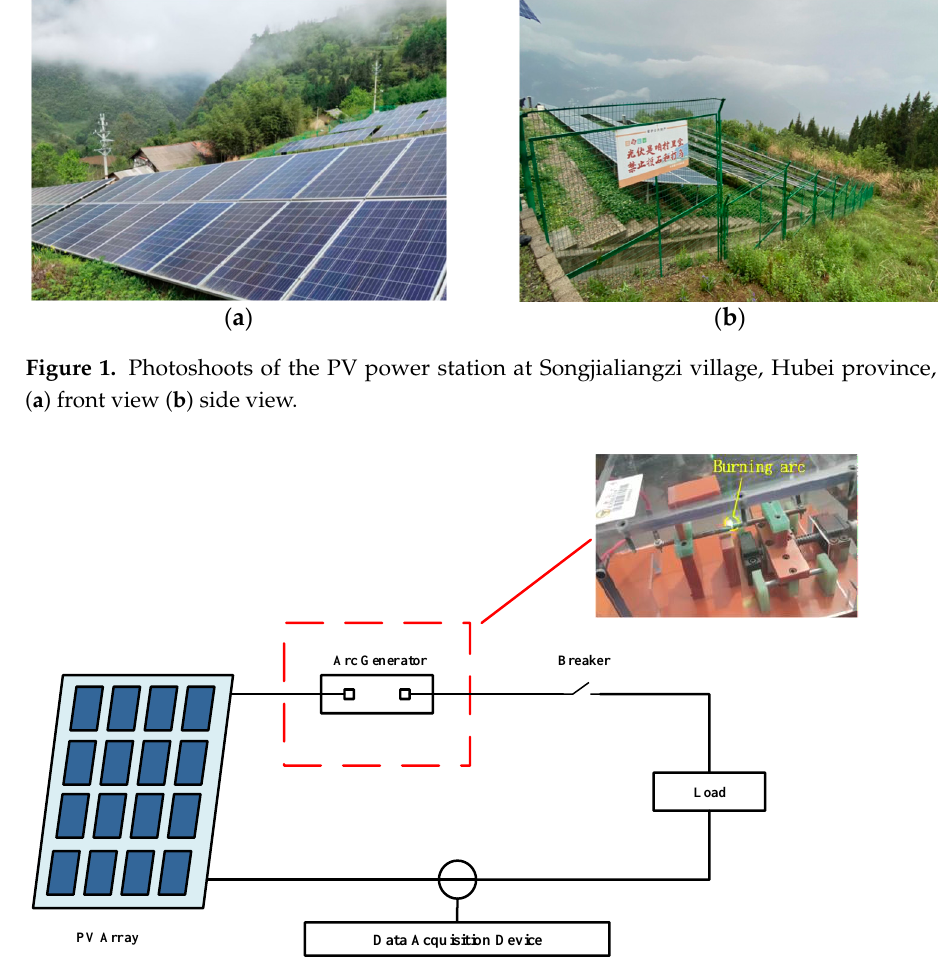
Figure 2. Schematic diagram of the series arc experimental